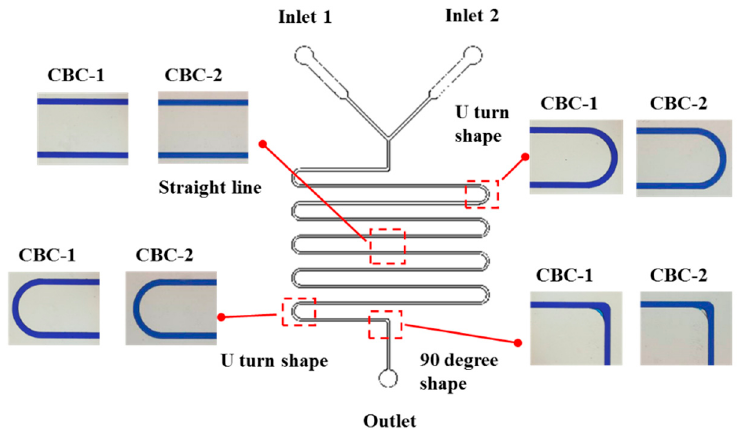
Figure 9. Microchannel design and leakage test for the CBC thermoplastic microchannels with a blue